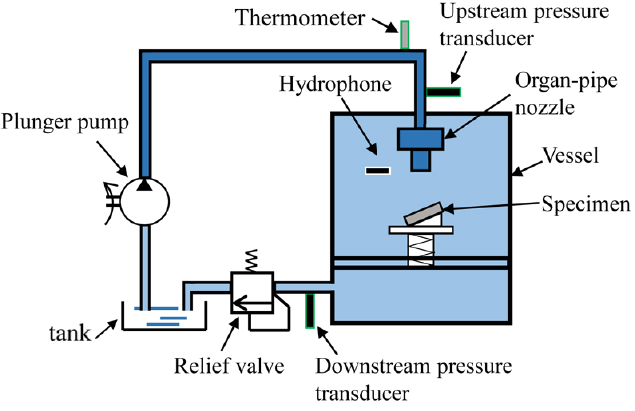
Figure 1. Schematic of the water jet erosion testing